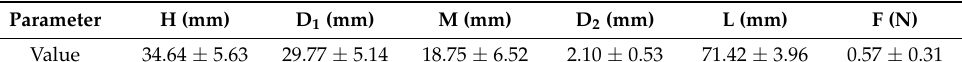
Figure 1. ( a ) The structure of a cherry tomato stem system; ( b ) physical measurements of cherry tomato basic shape pa- rameters.